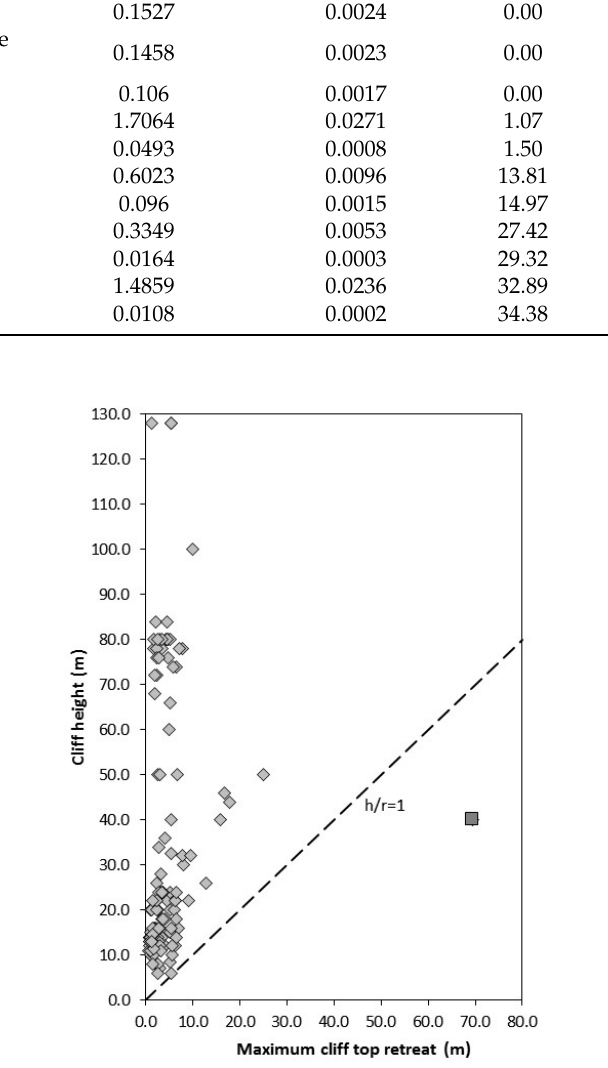
Figure 3. Maximum cliff top retreat caused by failures against cliff height. Square indicates the large translational slide occurred in the northern end of the study area.